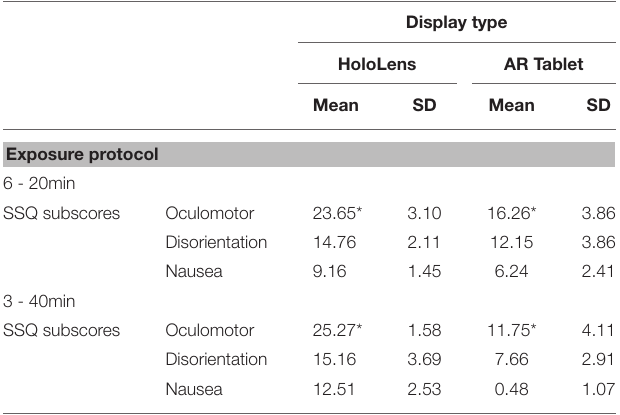
TABLE 2 | Simulator sickness questionnaire